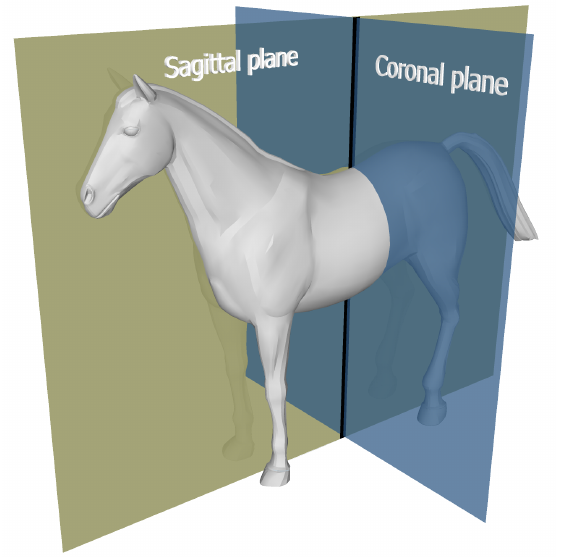
Figure 2. Planes for horse